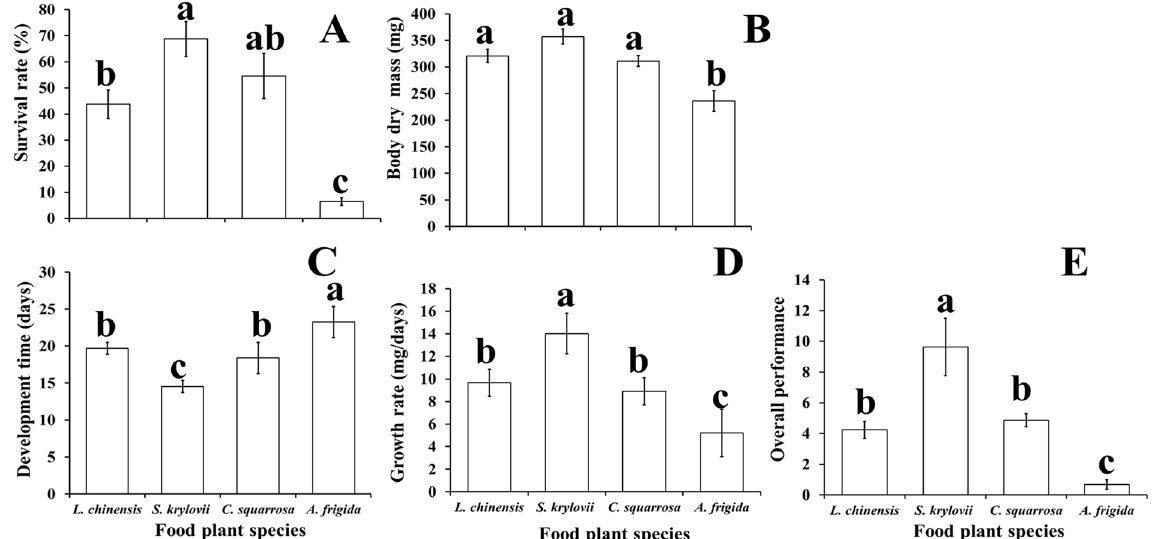
Figure 2. ( A ) O. asiaticus mean % survival rate from fourth instar to adult ± SD, ( B ) mean dry mass (mg ± SD) of adults, ( C ) mean developmental time (days ± SD) from fourth instar to adult, ( D ) growth rate (mg/day ± SD) and ( E ) overall performance ( ± SD) when fed on either L. chinensis , S. krylovii , C. squarrosa , or A. frigida ,